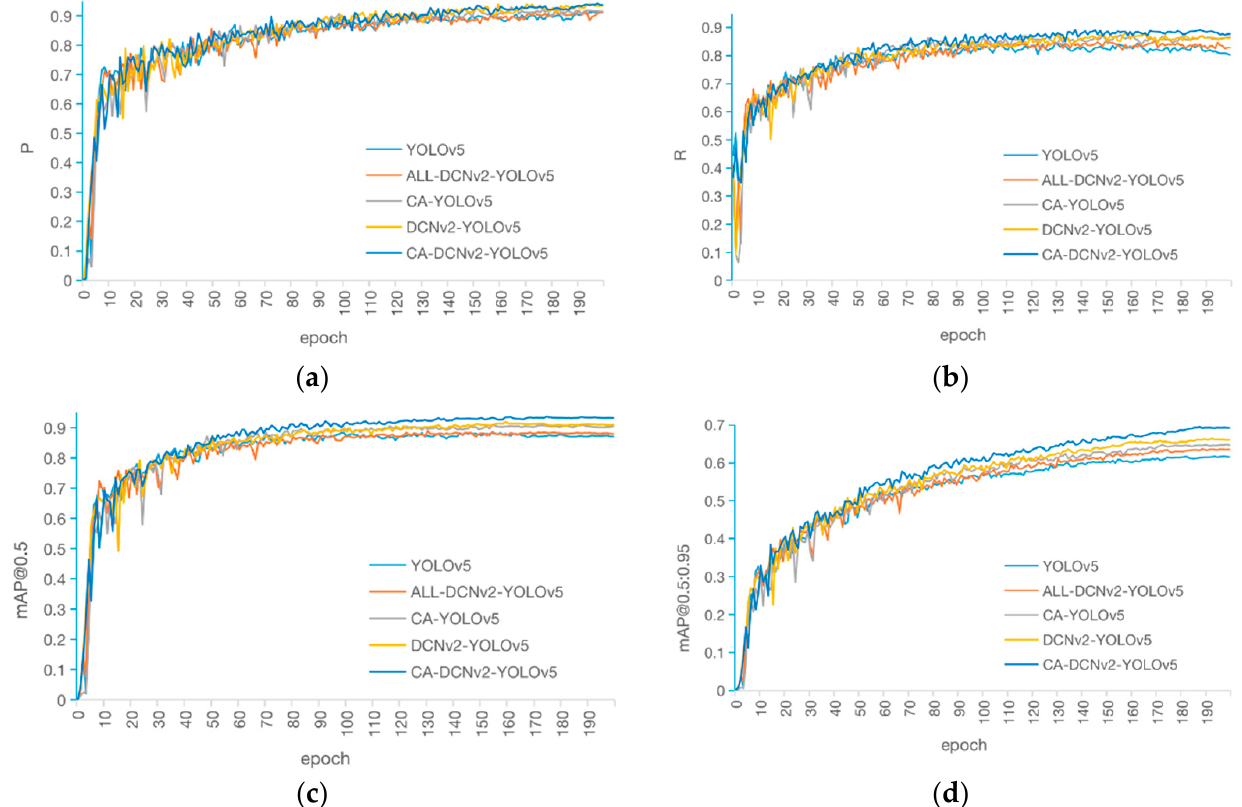
Figure 11. Evaluation index changes of different YOLO algorithms in the training process. ( a ) The precision change curve; ( b ) the recall change curve; ( c ) the change curve of mAP@0.5; ( d ) the change curve of mAP@0.5:0.95. Table 3. Ablation comparison experiment